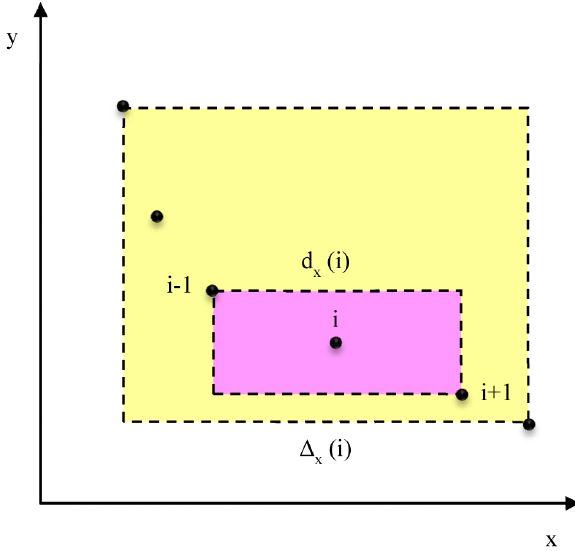
Figure 2: Crowding distance calculation parameters for sample.